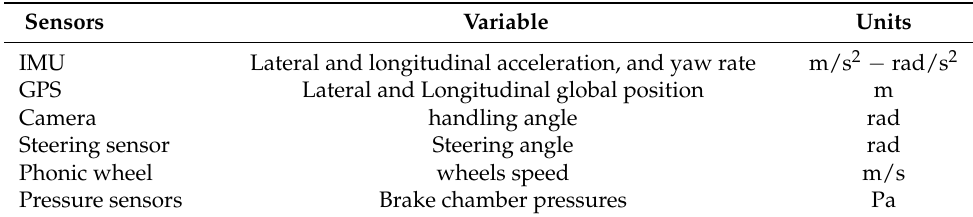
Table 1. Variables measured by